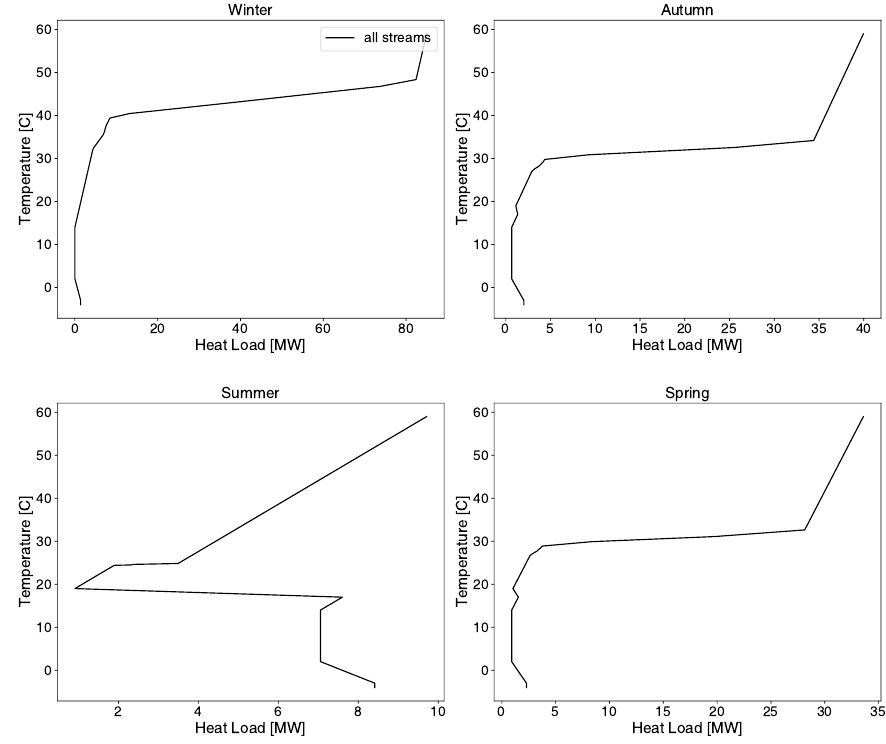
Figure A2. GCCs of the district in four